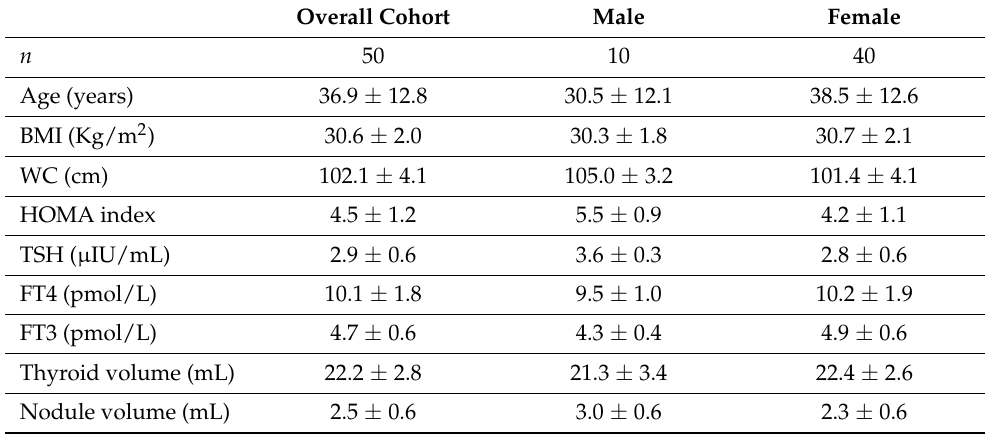
Table 1. Baseline parameters of the enrolled